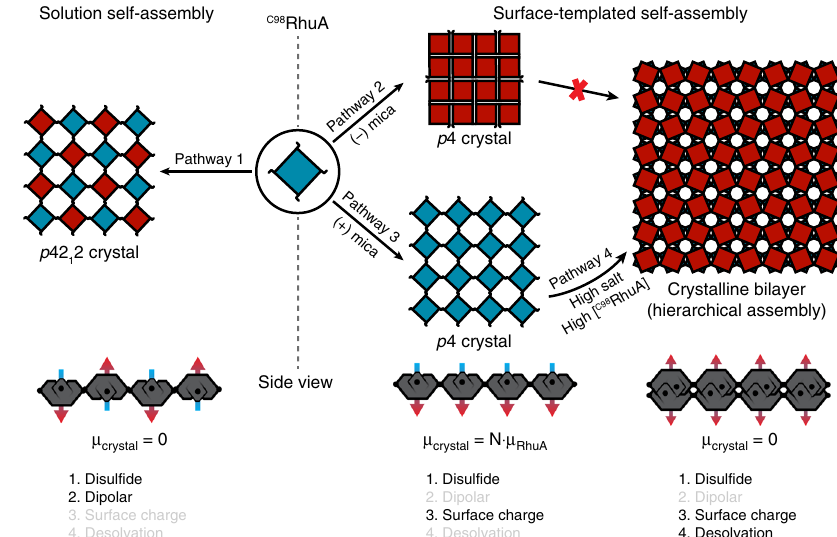
Fig. 4 Self-assembly pathways afforded by C98 RhuA patchiness and template effects. Overview of all C98 RhuA growth pathways and the self-assembly interactions responsible for their formation. The con fi guration-dependent dipole moment of each crystal morphology is also